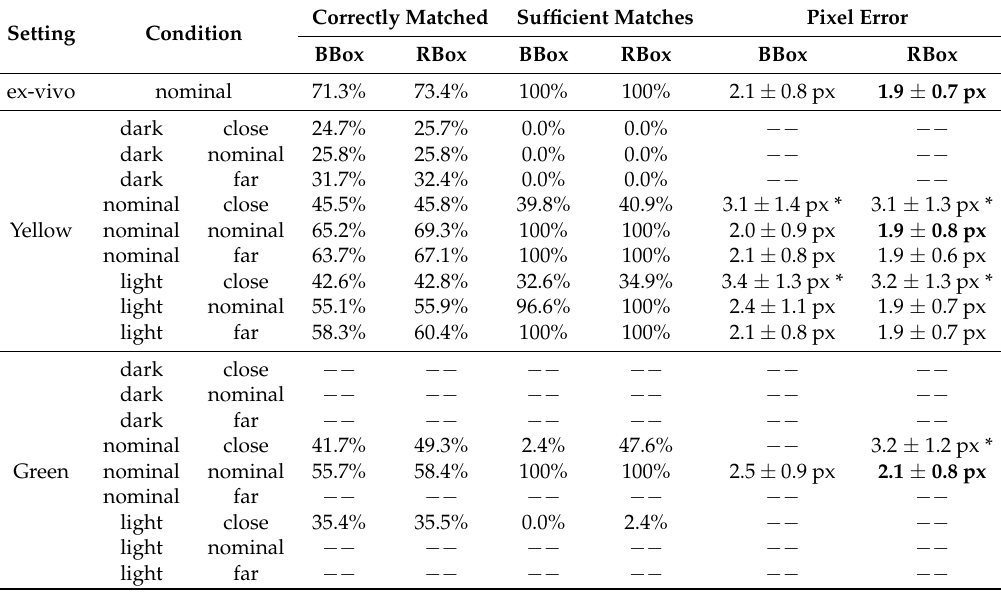
Table A2. Experiment 2: Matches found and pixel error with LMeDS; * with